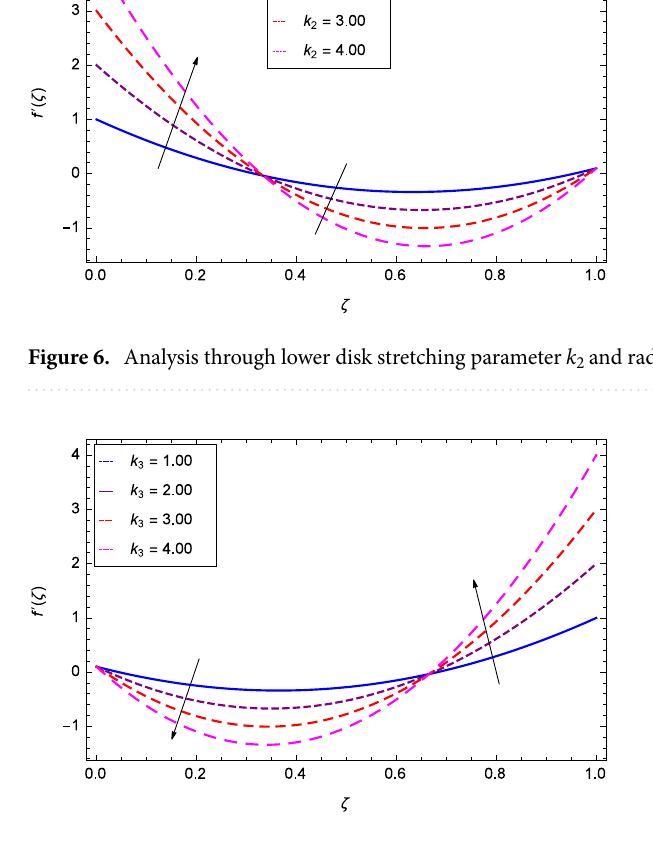
Figure 7. Analysis through upper disk stretching parameter k 3 and radial velocity f ′ ( ζ ).